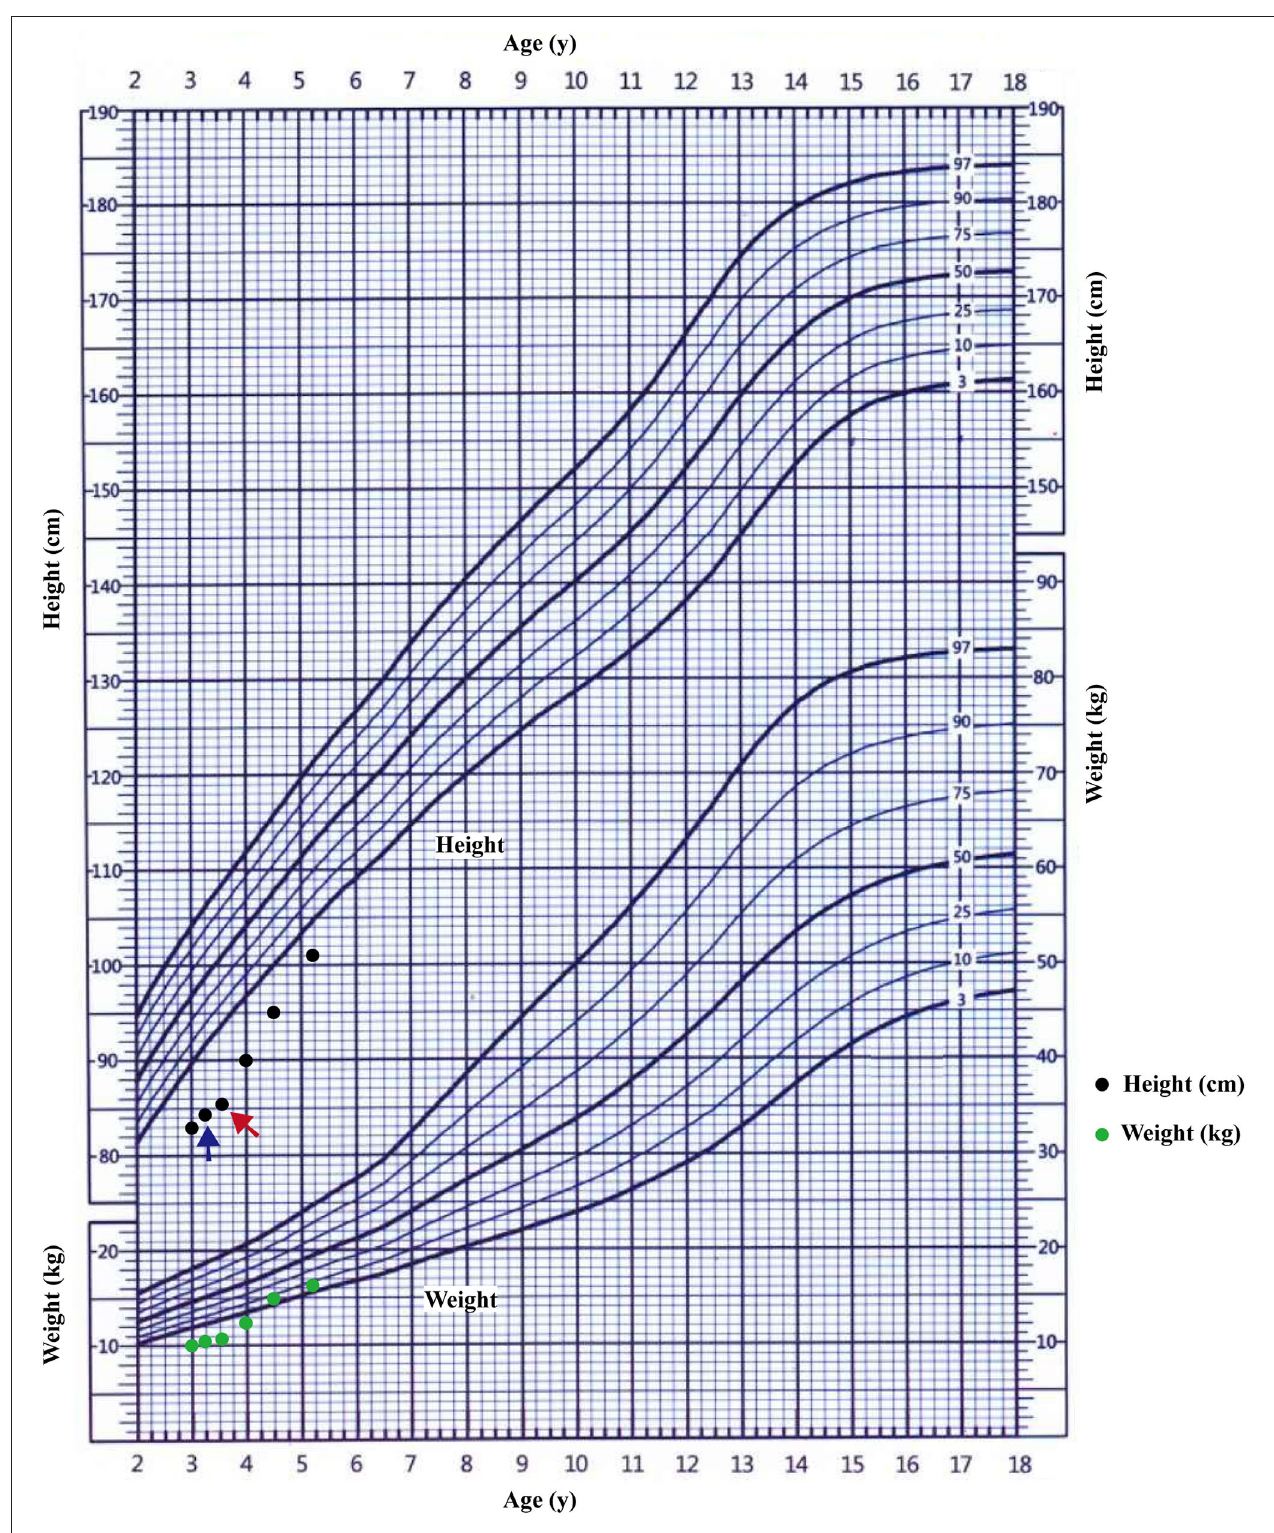
FIGURE 5 | The growth curve of the proband. The starting treatment with thiazide diuretics and potassium supplementation was showed by blue arrow; the starting treatment with rhGH was showed by red arrow.